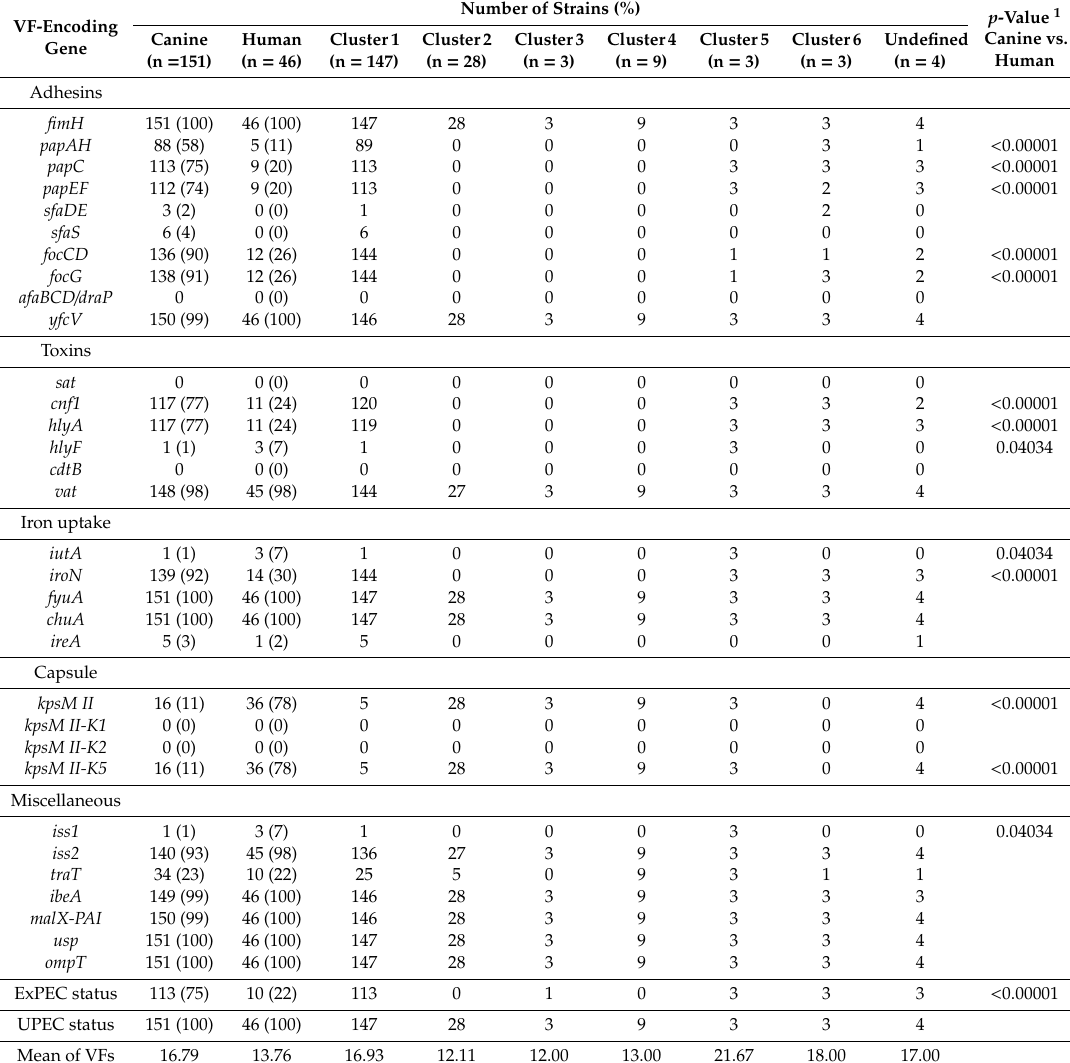
Table 7. Distribution of the VF-encoding genes detected among the 197 ST372 E. coli genomes according to strain origins (canine / human) and cluster types.